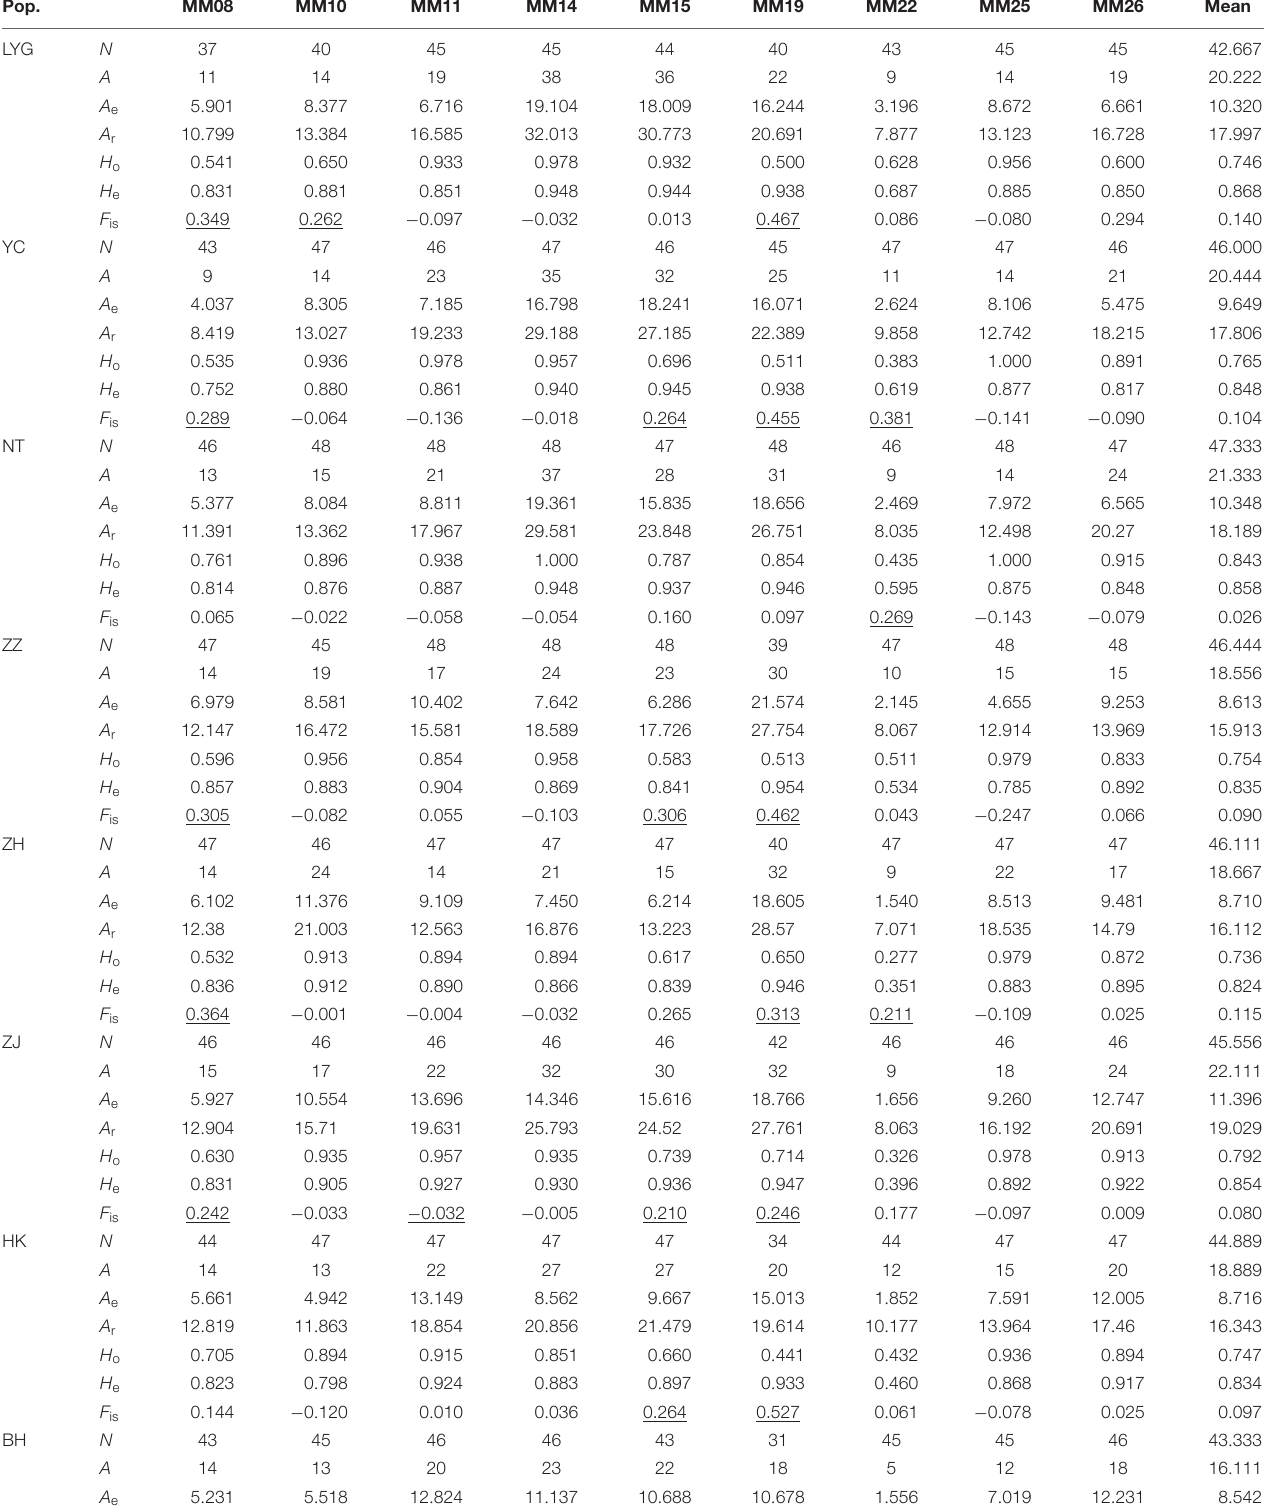
TABLE 2 | Allelic variability at nine microsatellite loci in clam M. meretrix along the coasts of China.